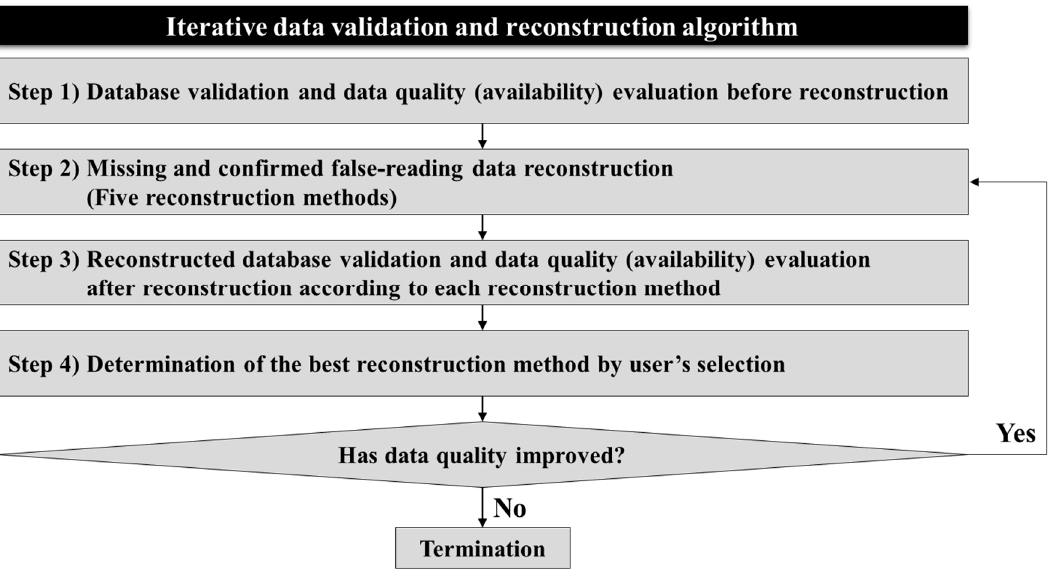
Figure 5. Process for iterative quality control algorithm.